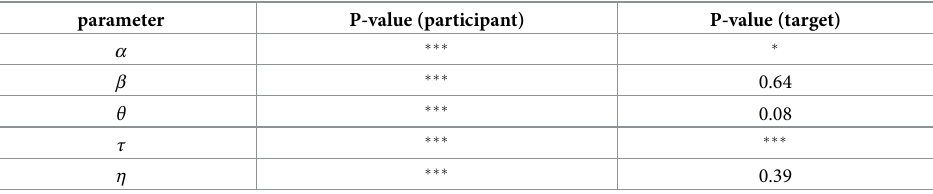
Table 1. Robustness of decomposition parameters across targets.